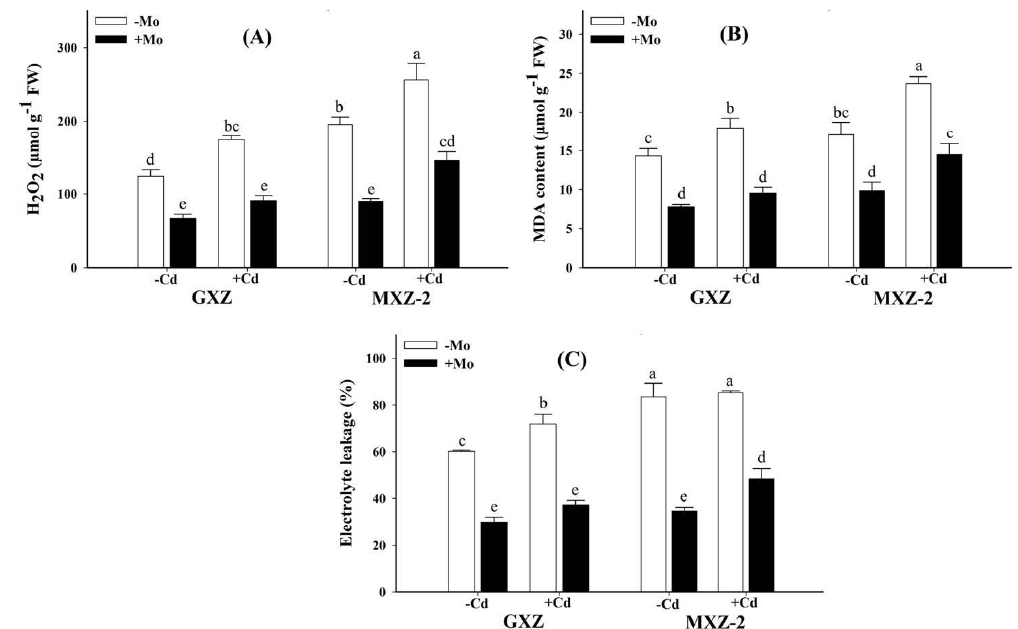
Figure 3. Influence of molybdenum (Mo) and cadmium (Cd) on; ( A ) hydrogen peroxide (H 2 O 2 ); ( B ) malondialdehyde (MDA) and ( C ) electrolyte leakage (EL) in leaves of two fragrant rice Guixiangzhan (GXZ) and Meixiangzhan-2 (MXZ-2) cultivars. Both fragrant rice cultivars were treated with two molybdenum levels: 0 µM (–Mo) and 1 µM (+Mo), against two cadmium levels: 0 µM (-Cd) and 100 µM (+Cd) in modified Hoagland solution. Vertical bar above indicates standard error of four replicates. Different lowercase letters (a, b, c, etc.) represent significant differences according to the LSD-test ( p < 0.05, n = 4).